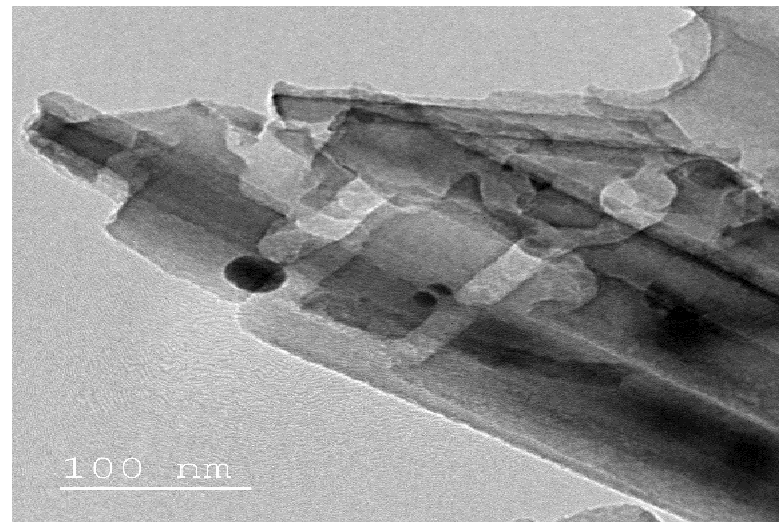
Figure 8. TEM image of the PbS/SiNWs nanohybrid .